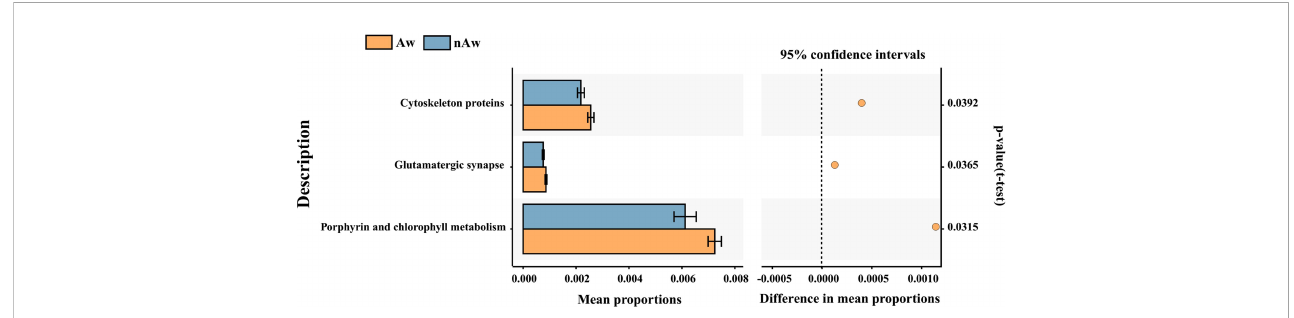
FIGURE 8 Predicted functional. Predicted functional differences between Aw and nAw microbiomes. A total of three metabolic pathways differed signi fi cantly between Aw and nAw infants. Pathways that were more abundant in Aw are on the positive side (orange circle with 95% con fi dence interval). Mean proportions are shown in stacks for Aw (orange) and nAw (blue). Differences in mean proportions: mean proportion in Aw minus mean proportions in nAw. Tests were conducted at KEGG hierarchical level 3, which included 294 pathways present in all samples. Aw, atopic wheezing group; nAw, non- atopic wheezing